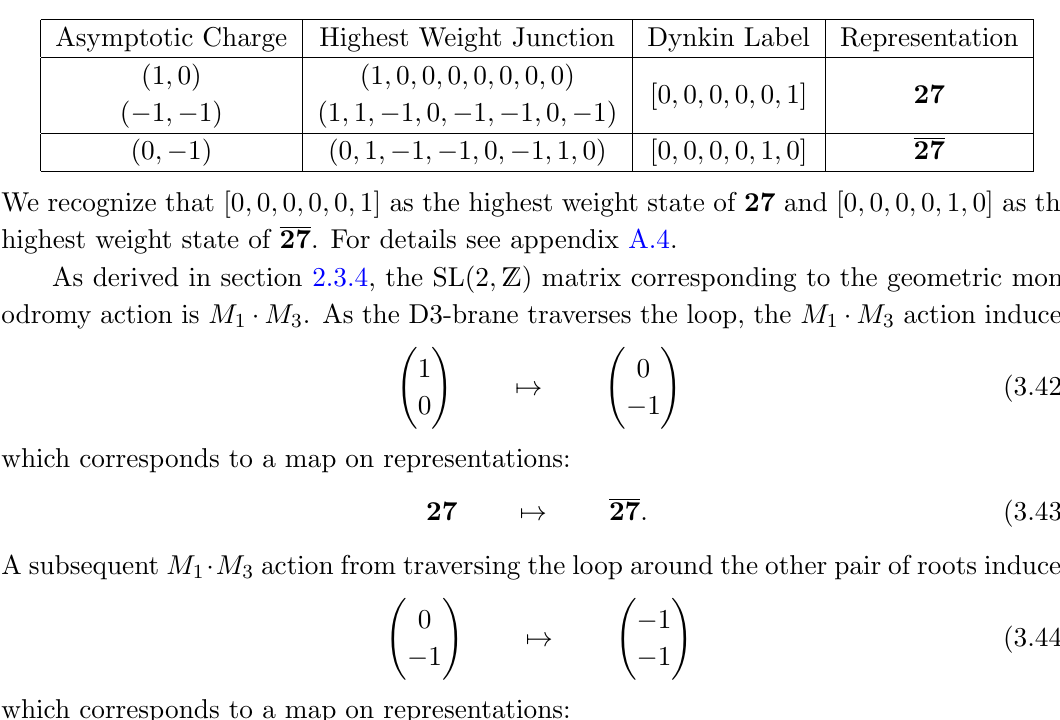
Figure 11 . The outer-automorphism acting on E 6 diagram of e 6 leads to F 4 diagram of f 4